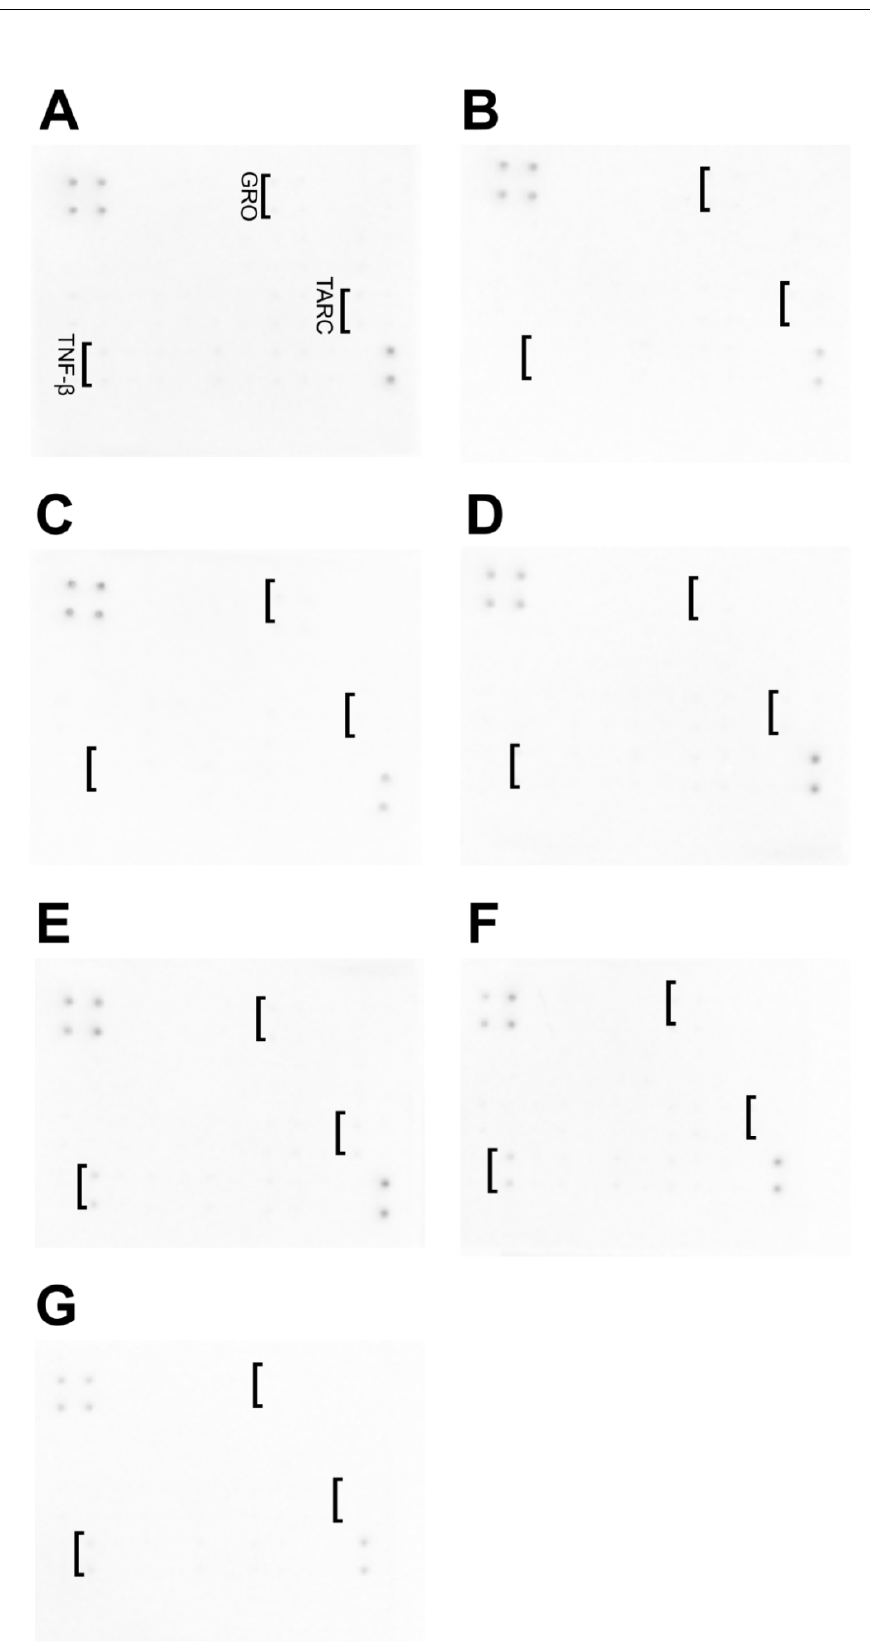
Figure 10. Analysis of the expression of cytokine proteins of the HFFF-2 cells after being treated with the following: ( A ) control; ( B ) GN; ( C ) GO; ( D ) ZnO; ( E ) Cu; ( F ) GNZnOCu; ( G ) GOZnOCu.